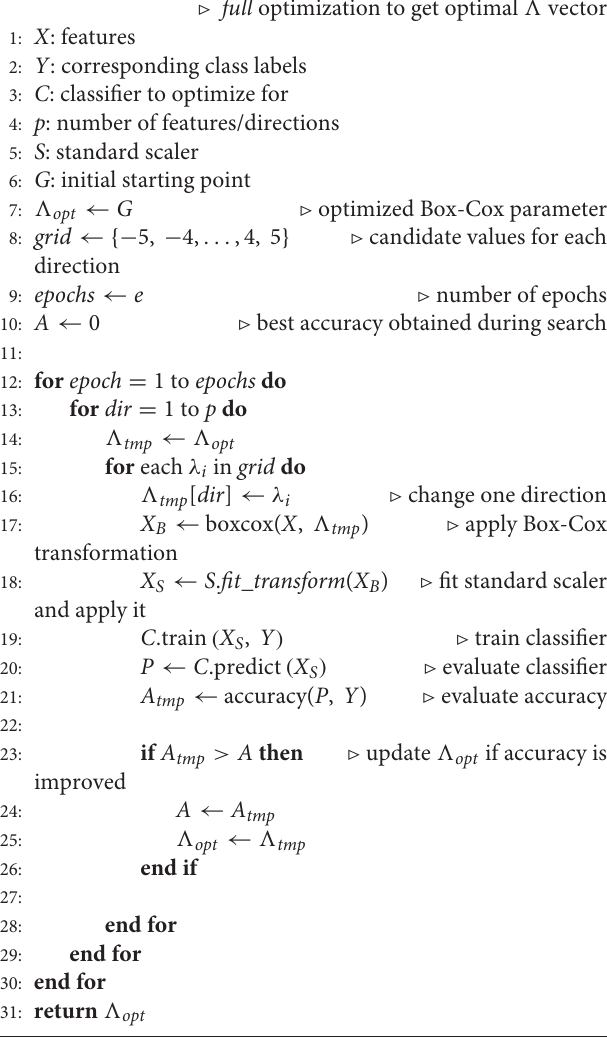
Algorithm 6 : Iterative grid search( X , Y , C ) ⊲ full optimization to get optimal 3